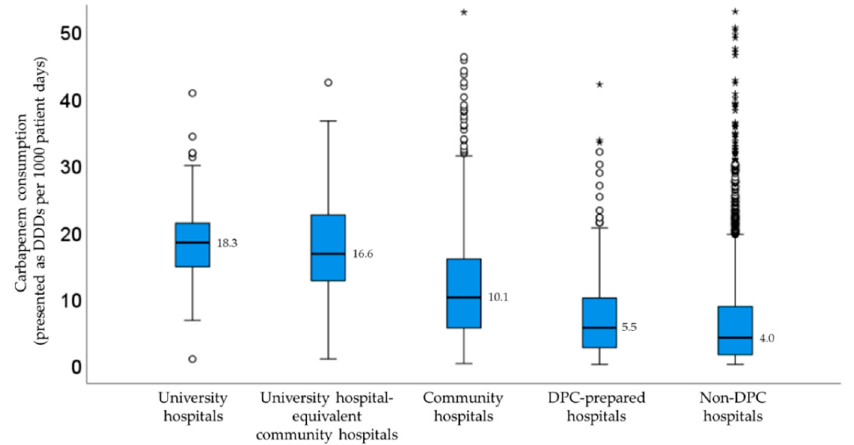
Figure 2. Median carbapenem consumption stratified by facility type. The outliners were plotted on the box plot as a small circle and a star.